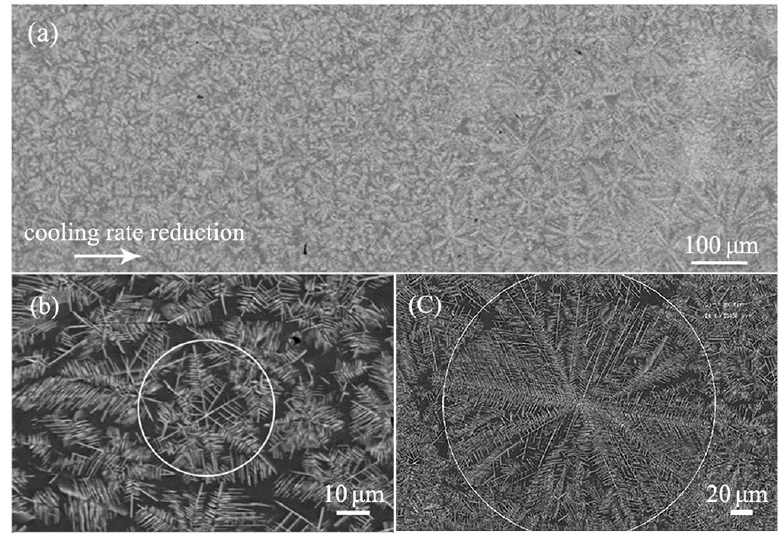
Figure 7. SEM BSE of the cross-section of the cylindrical sample in suction casting Al–8 wt.% Mn alloy: ( a ) full sample; ( b ) at the edge of the sample; ( c ) at the center of the sample. Detailed information on the microstructure at the center of the sample is provided in Figure 8.